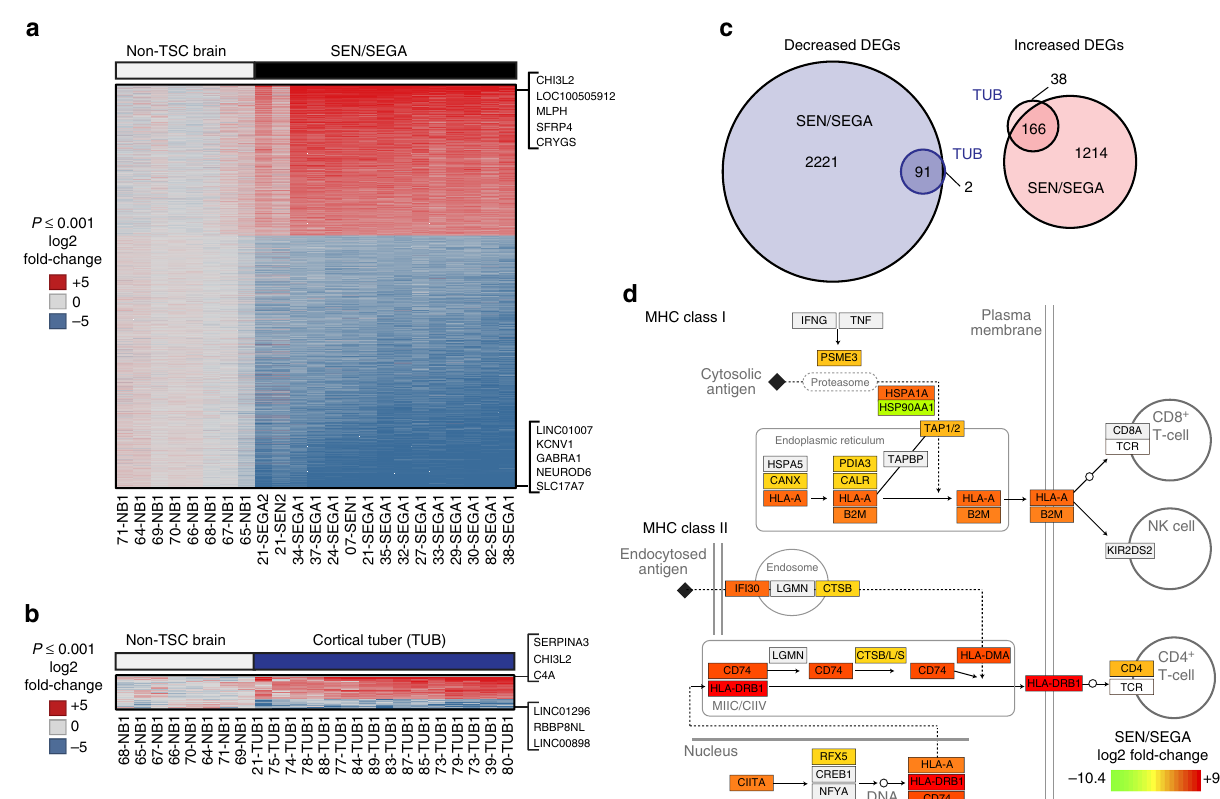
Figure 4 | Shared gene expression features of TSC-associated brain lesions. ( a , b ) Genes differentially expressed in SEN/SEGA ( a ) or cortical tubers (TUB) ( b ) compared to non-TSC brain (NB) samples (log2 fold-change þ / (cid:2) 4 2; adjusted P o 0.001) are coloured by log2-transformed fold-changes according to the scale (blue: low; red: high). Top 5 and top 3 increased and decreased DEGs are indicated for SEGAs ( a ) and cortical tubers ( b ), respectively. ( c ) Venn diagrams showing similarity in DEGs between TUB and SEGA (blue: decreased DEGs; red: increased DEGs). Circles are sized according to DEG number. ( d ) Molecular map of antigen processing and presentation modified from KEGG ID hsa04612. Genes are coloured according to log2 fold-changes in SEN/SEGA according to the